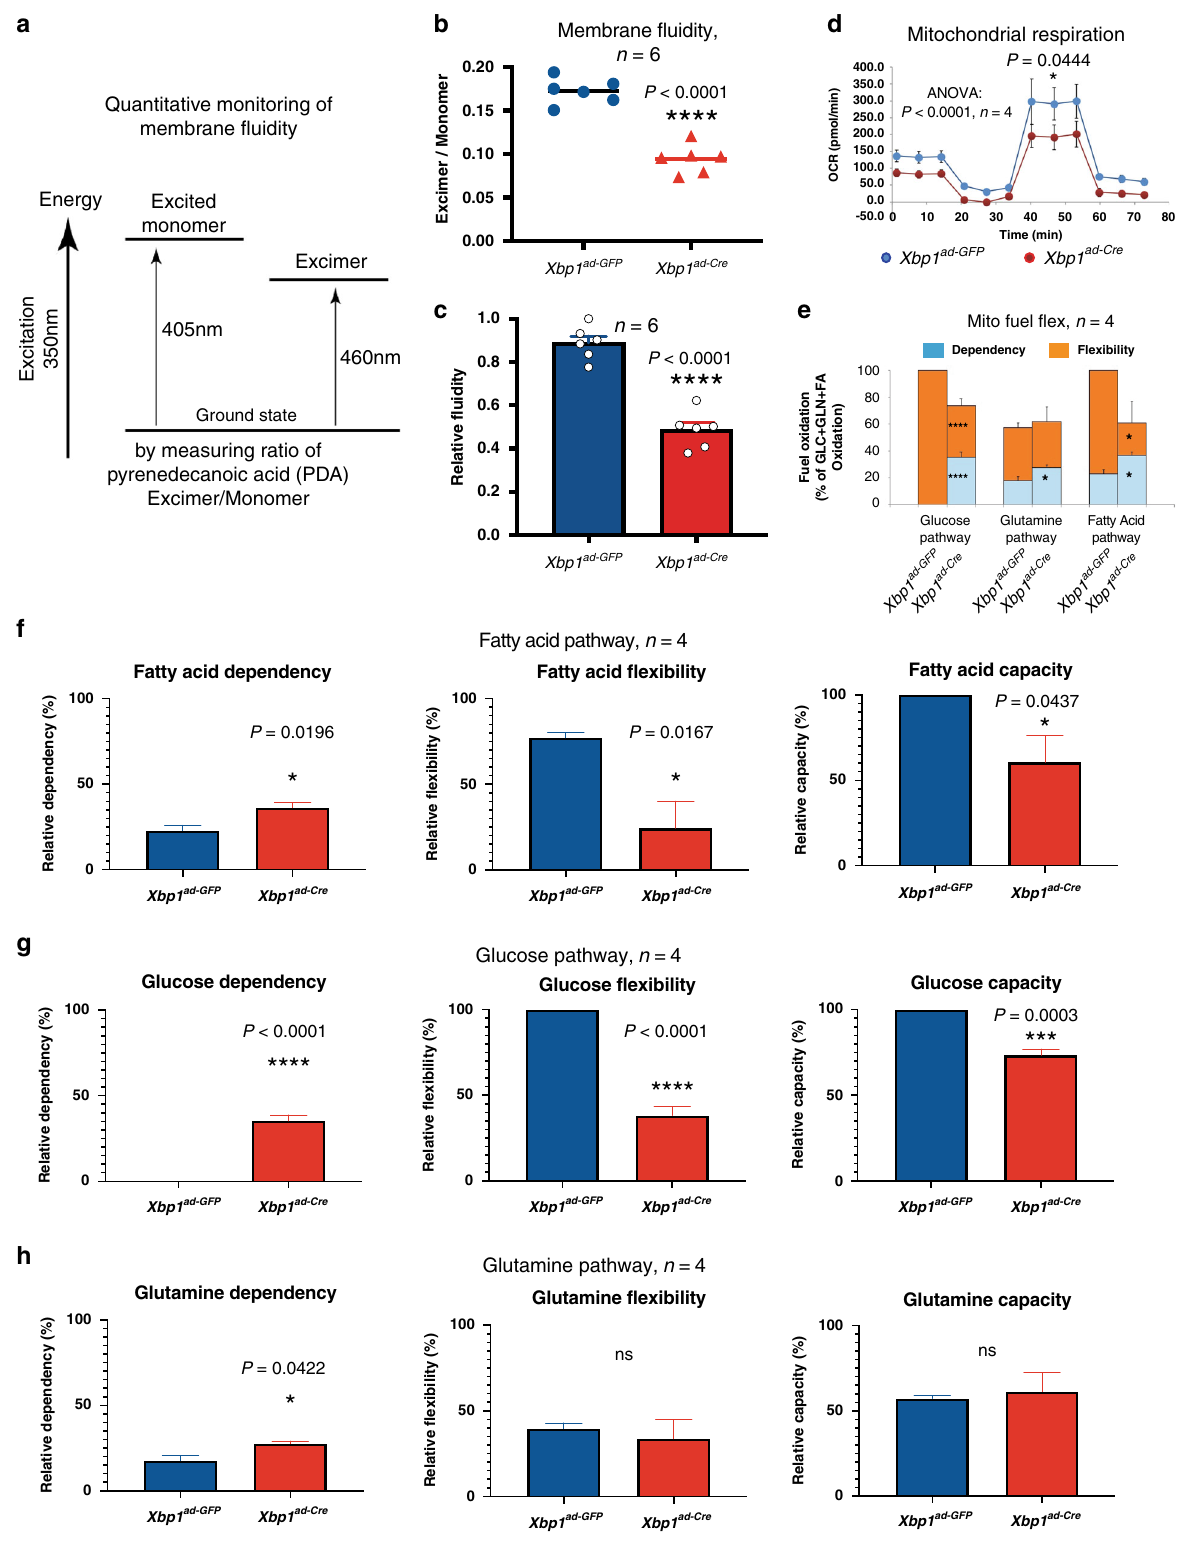
regulators in central and peripheral systems remain to be clock to coordinate liver glucose and lipid homeostasis, but more investigated. causal links between the 12-h clock and NAFLD susceptibility, In summary, our fi ndings underscore an intimate and unap- including detailed characterizations of the 12-h clock and its preciated relationship between the 12-h clock and the main- harmonics with the 24-h clock in other conditions, e.g., prolonged tenance of metabolic homeostasis through the control of lipid constant darkness, feeding or behavior changes that disrupt the homeostasis and the synchronization of systemic EE. Our data 12/24-h rhythmicity, and exploration of additional 12-h clock NATURE COMMUNICATIONS| (2020) 11:6215